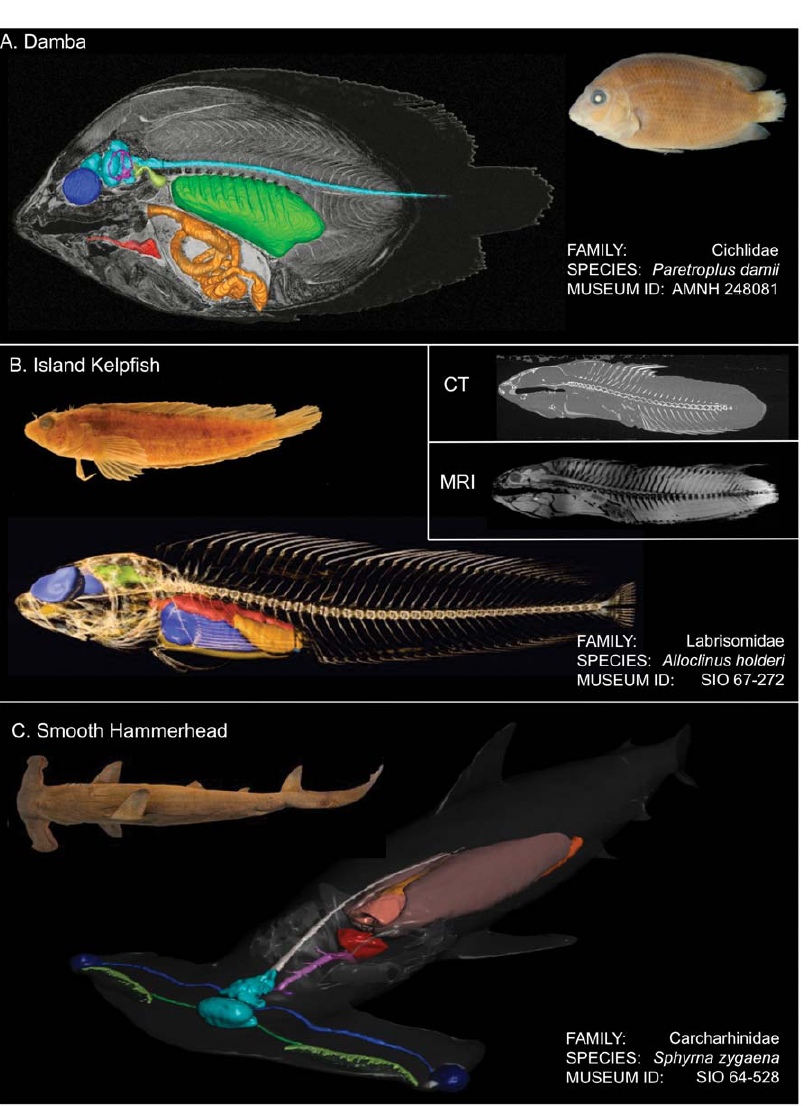
Figure 5. Examples of 3D segmentation and rendering of DFL data. (A) This damba, Paretroplus damii (AMNH 248081, SL 76 mm) was imaged at 7 T with the following 3D FLASH pulse sequence parameters: FA=15 u , TR=24.07 ms, TE=11.92 ms, slice thickness=100 m m, slice matrix=300 6 1024 6 500, resolution=100 m m 3 , averages=2. MRI slice data is overlaid with a selection of segmented soft tissue structures color- coded as follows: light blue=brain and spinal cord; dark blue=eyes; magenta=vestibular labyrinth; green=gas bladder; light brown=alimentary tract; red=heart and dorsal aorta. (B) Both MRI and CT data were acquired for this island kelpfish, Alloclinus holderi (SIO 67-272, SL 94 mm). A selection of soft tissue structures were segmented from MRI data and are color-coded as follows: blue=eyes; green=brain; red=alimentary tract; light brown=ovaries; purple=liver. Segmented soft tissues were co-registered with a volumetric rendering of CT imaged hard tissue structures acquired by The University of Texas High-Resolution X-ray Computed Tomography Facility (UTCT) (slice thickness 42 m m). (C) This smooth hammerhead, Sphyrna zygaena (SIO 64-528; SL 104 mm) was imaged at 3 T with the following 3D FSPGR pulse sequence parameters: FA=35 u , TR=9.86 ms, TE=4.11 ms, slice thickness=900 m m, slice matrix=512 6 512 6 236, resolution=683 m m 3 , averages=2. It was scanned in 4 sections and pieced together in Amira for segmentation. A selection of segmented soft tissue structures are color-coded as follows: brown=alimentary tract; dark blue=eyes; green=olfactory system; light blue=brain; magenta=dorsal aorta; puce=liver; red=heart; white=spinal